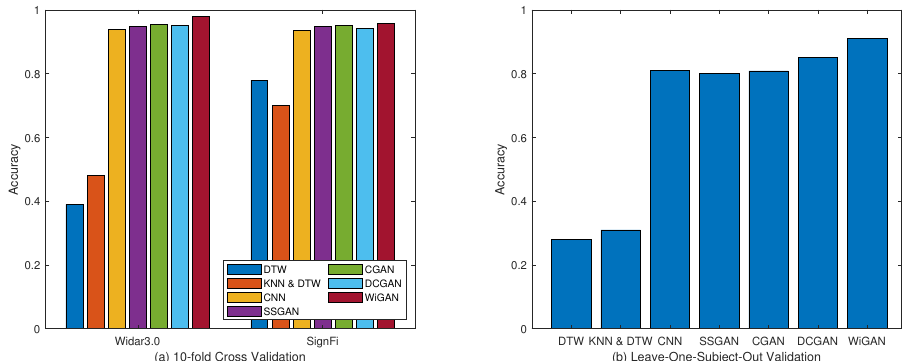
Figure 9. Performance comparison of supervised GANs under the two validation methods. ( a ) 10-fold cross validation. ( b ) Leave-one-subject-out